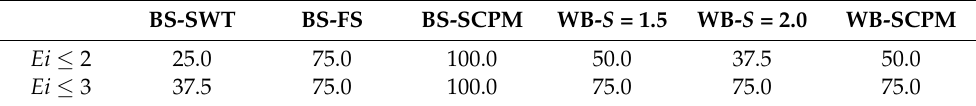
Table 5 gives the summary of percentage in error index Ei . The error index Ei ≤ 2 and Ei ≤ 3 indicate the prediction results with ± 2 and ± 3 times scatter band of fatigue life, respectively. Compared with other models, the BS method with the SCPM criterion is more applicable for 30CrMnSiA steel under asynchronous loadings. Table 5. Percentage in two error indexes of each model (unit: